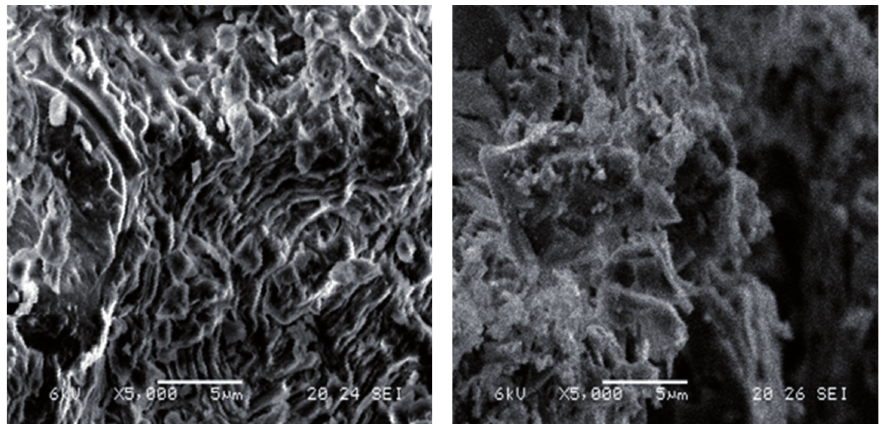
F 5: SEM micrographs of raw material and optimum activated carbon AC-H PO